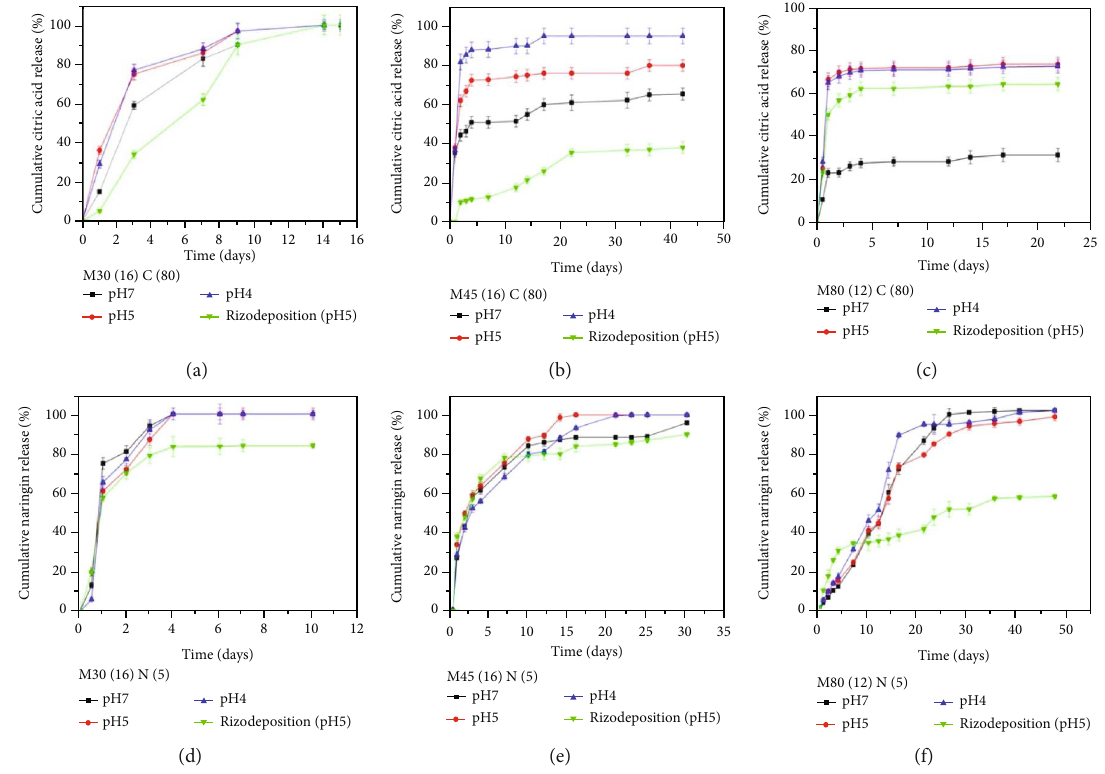
Figure 46: Percentage of cumulative in vitro release pro fi les of (a) microcapsules containing citric acid: M30(16)C(80), M45(16)C(80), and M80(12)C(80); (b) microcapsules containing naringin: M30(16)N(5), M45(16)N(5), and M80(12)N(5), under di ff erent pH solutions. The release values displayed in the graphs are an average of three independent release experiments employing microcapsules of the same type, but from di ff erent batches (error bars represent standard deviations, n = 3 ) [134].